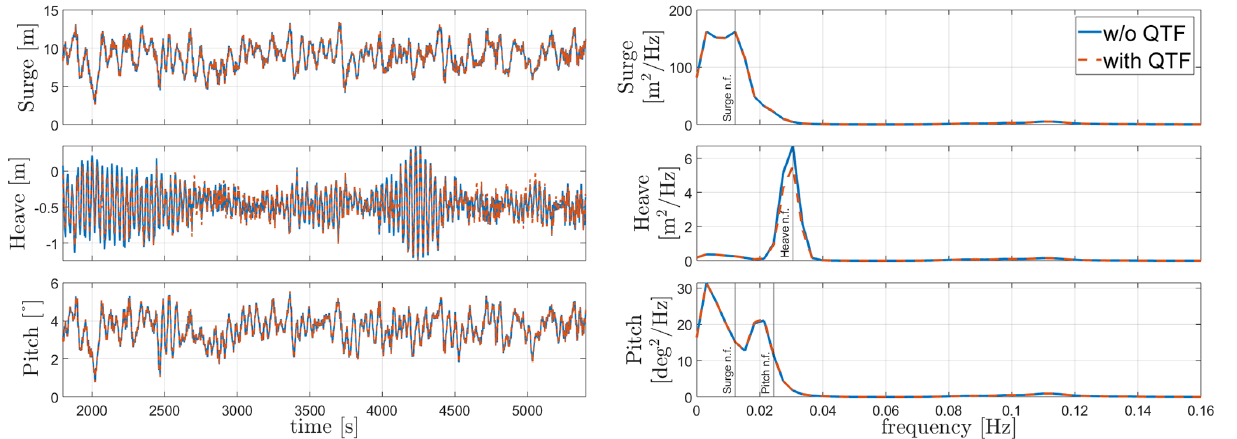
Figure 11. WindCrete response to NTM wind and ESS ( T p = 9s ,H s = 5 . 11m).